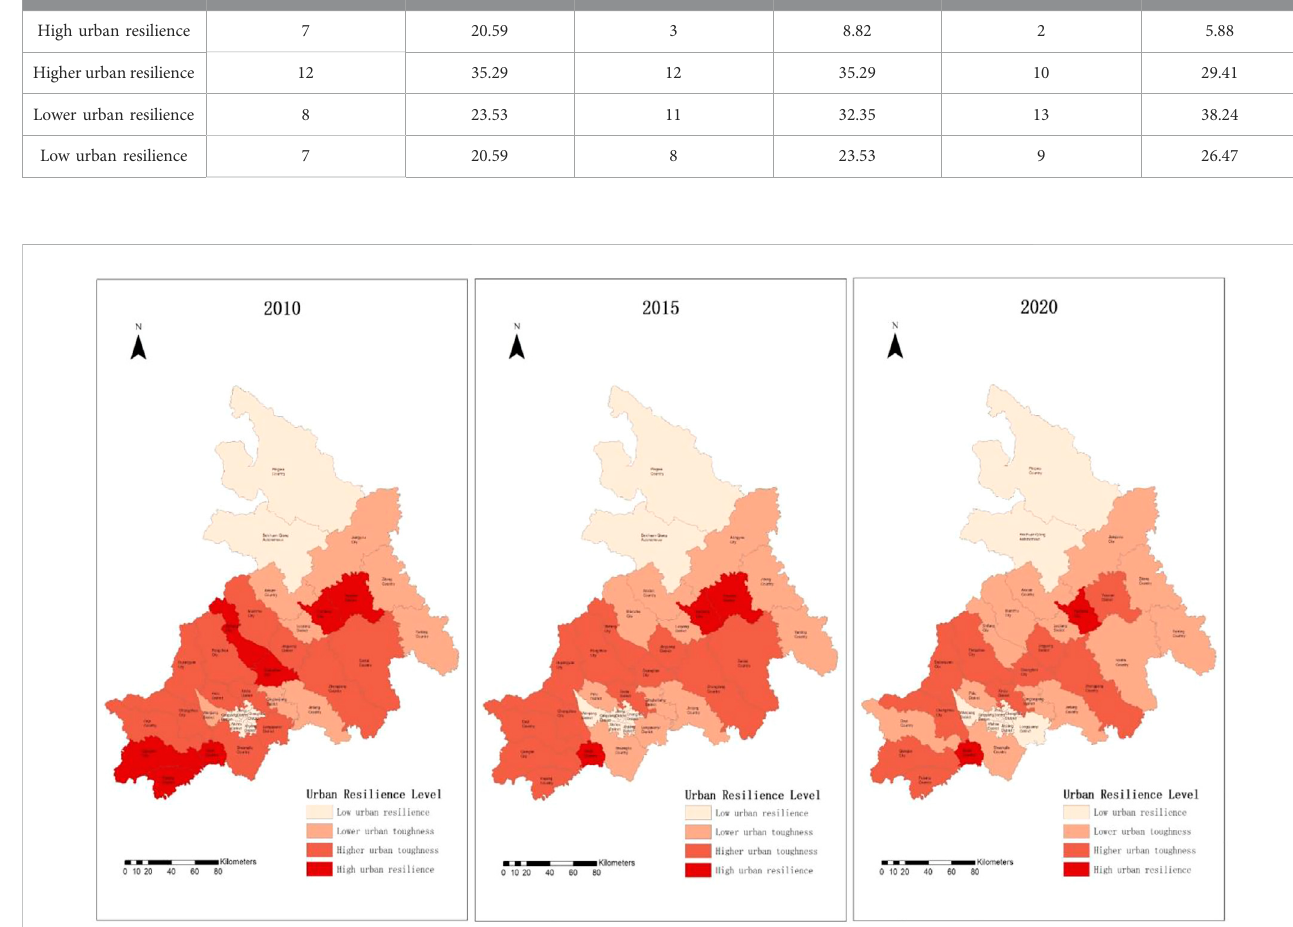
FIGURE 4 Spatial pattern and changes in urban resilience